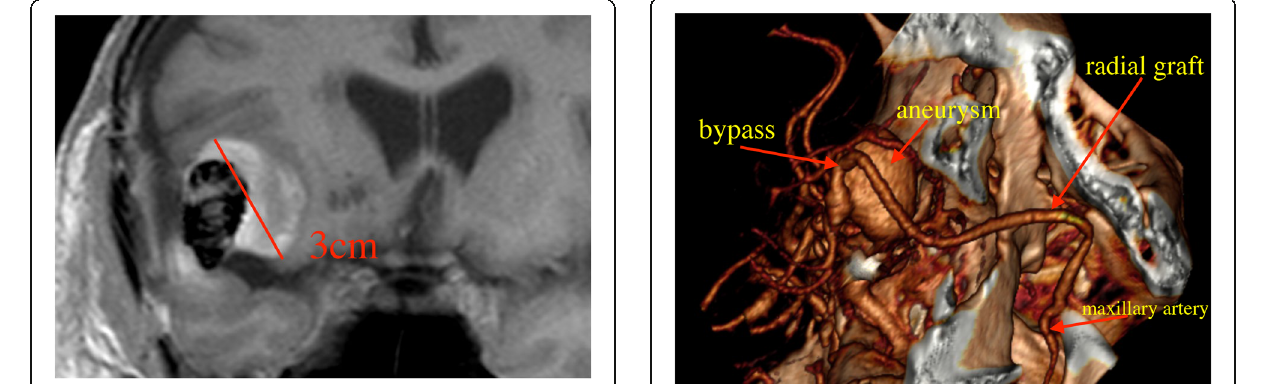
Fig. 1 MRI revealed a giant fusiform thrombosed aneurysm in M1 segment of the right MCA